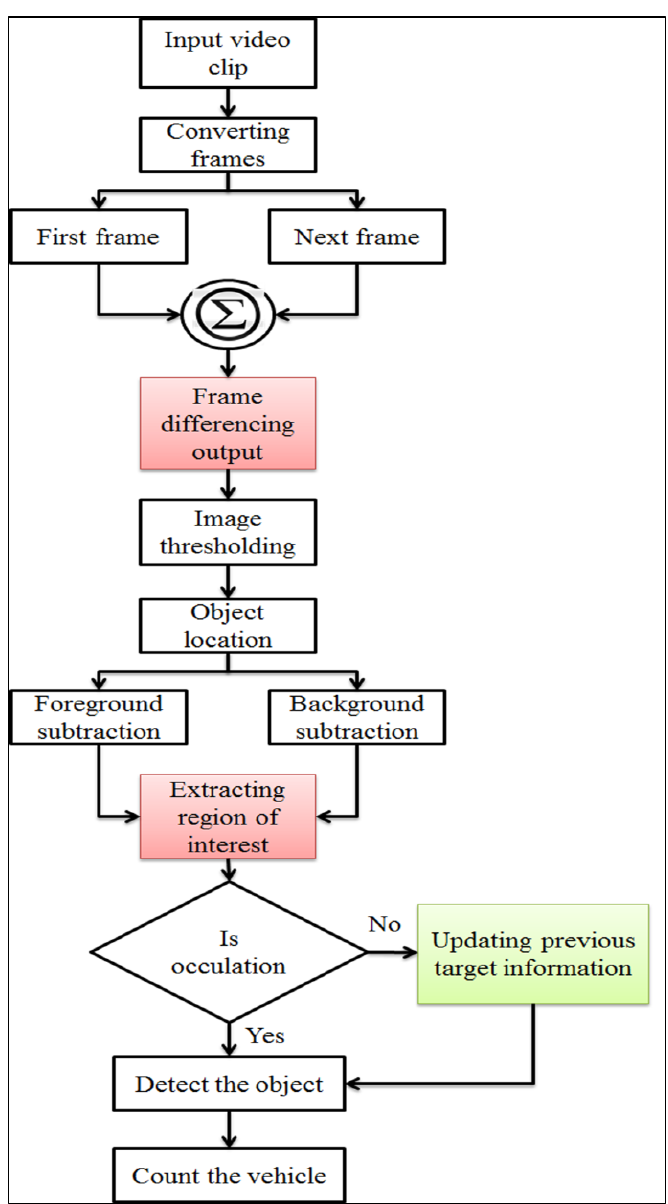
Figure 2: Architecture of moving vehicle tracking